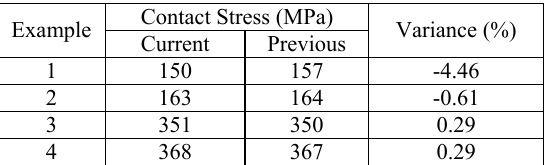
Table 3: Contact Stress Comparison for Examples